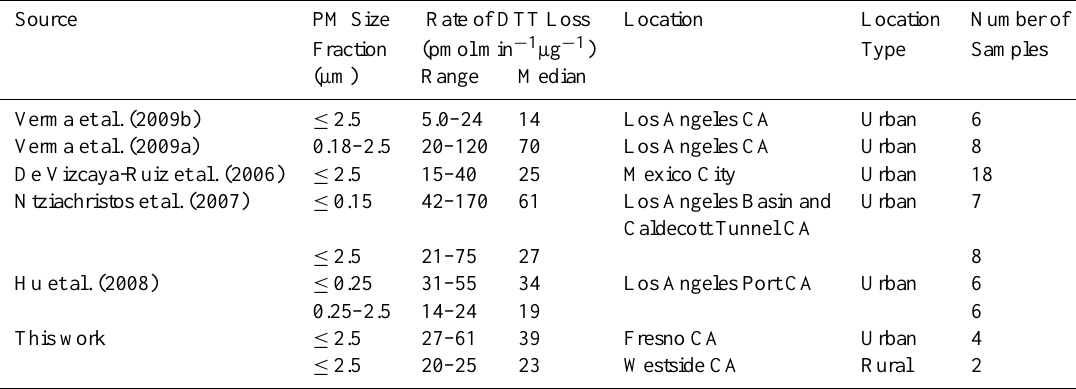
Table 3. Reported rates of DTT loss from ambient particulate matter.